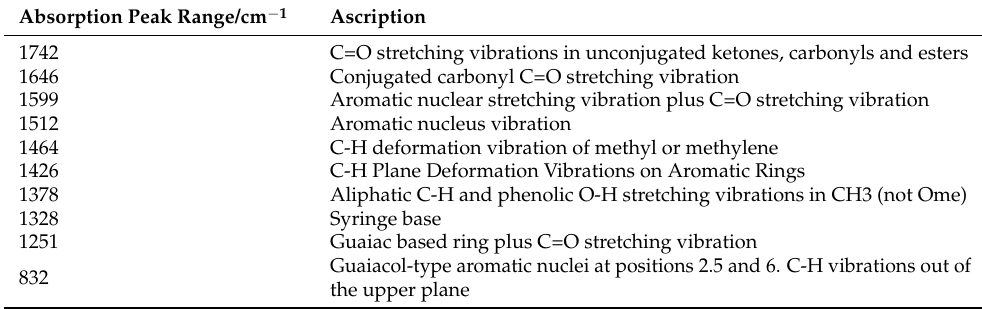
Table 3. PbrSAUR13, PbrSAUR52 overexpressed pear fruit G-type lignin and S-type lignin band intensity ratio.